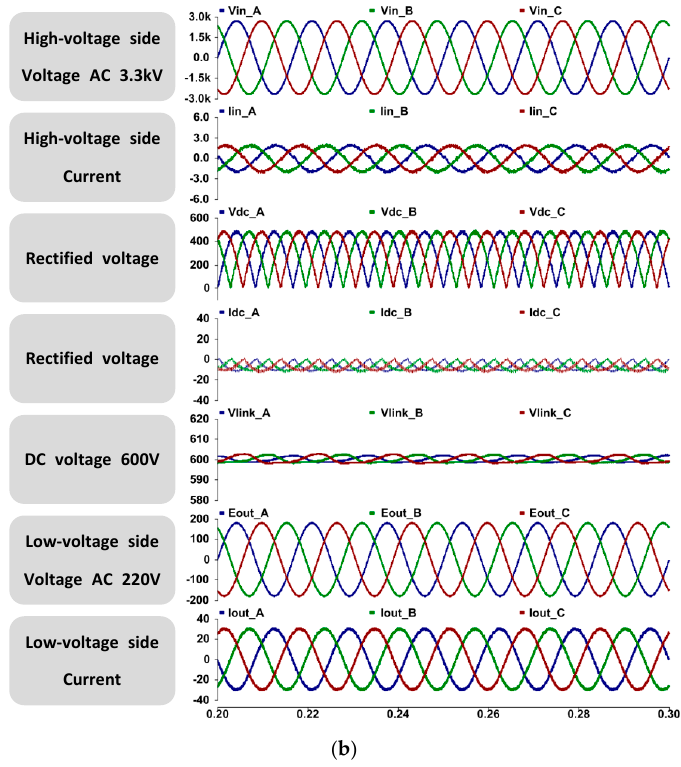
Figure 8. Simulation results in normal operation: ( a ) forward power flow; and ( b ) reverse power flow.